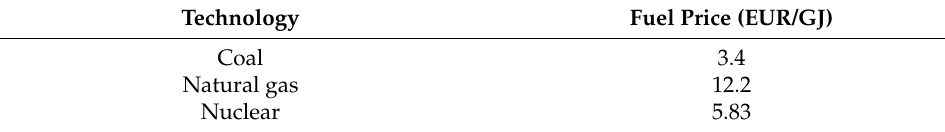
Table 4. Fossil fuel considered